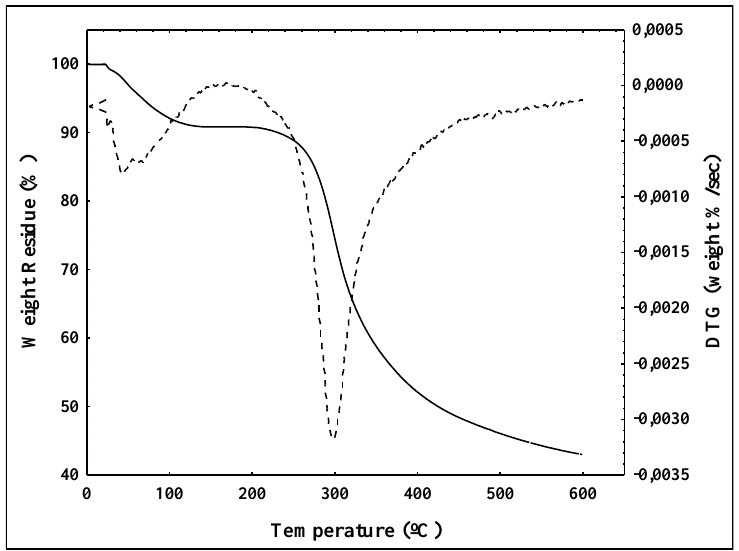
Figure 5. Thermogravimetric curve and differential weight residue curve of SF/CHI 50:50 blended